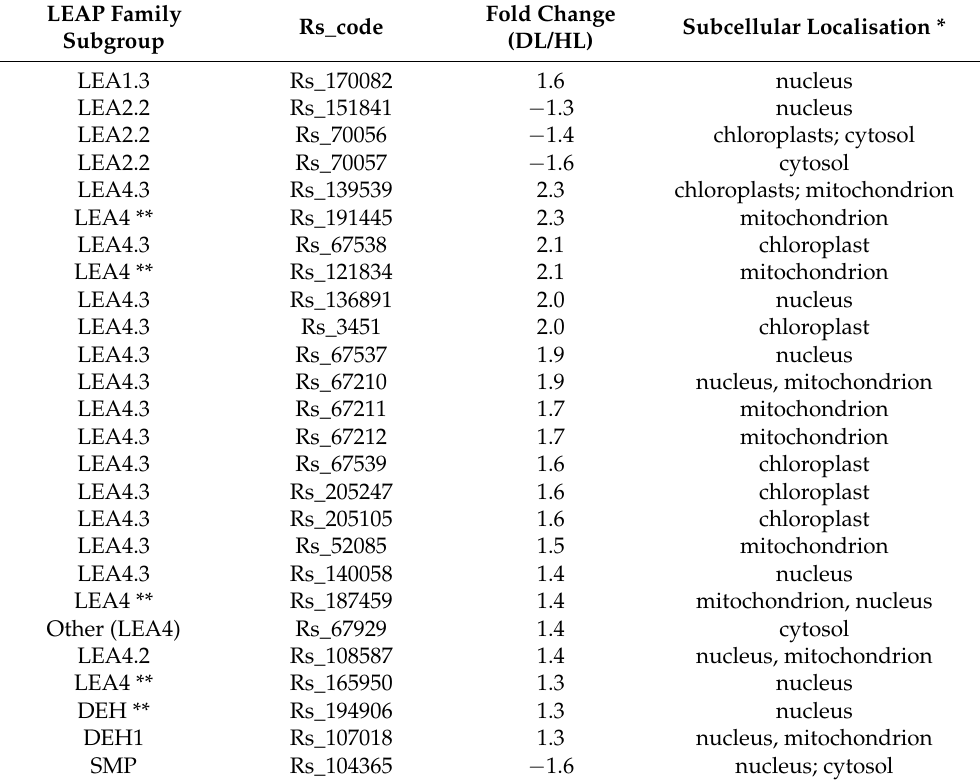
Table 3. Differentially abundant LEAPs in R. serbica upon